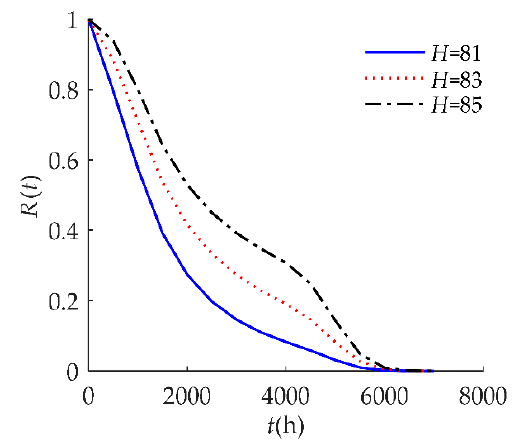
Figure 6. Sensitivity analysis of R ( t ) on H for example I.